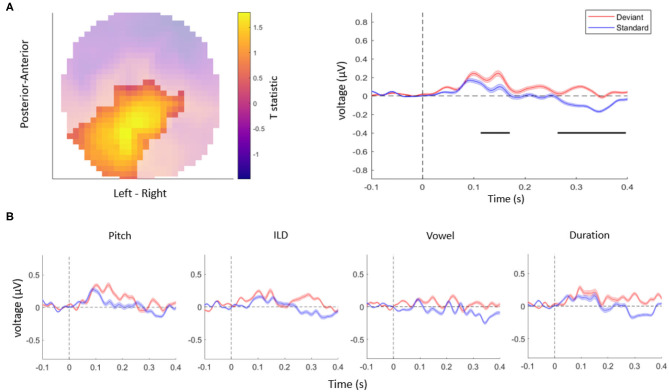
(A) The topography (left) and time-course (right) of the mismatch response. The highlighted topography cluster represents the significant difference between deviants and standards. Based on this cluster, the average waveform of the evoked response is plotted separately for auditory standards (blue) and deviants (red). The horizontal bars (black) indicate time points with a significant difference between deviants and standards. Shaded areas denote SEM (standard error of the mean) across participants. (B) The average response to acoustic standards (blue) and deviants (red) for different feature conditions, extracted from the same cluster as in (A). No interaction effects were significant after correcting for multiple comparisons across channels and time points.